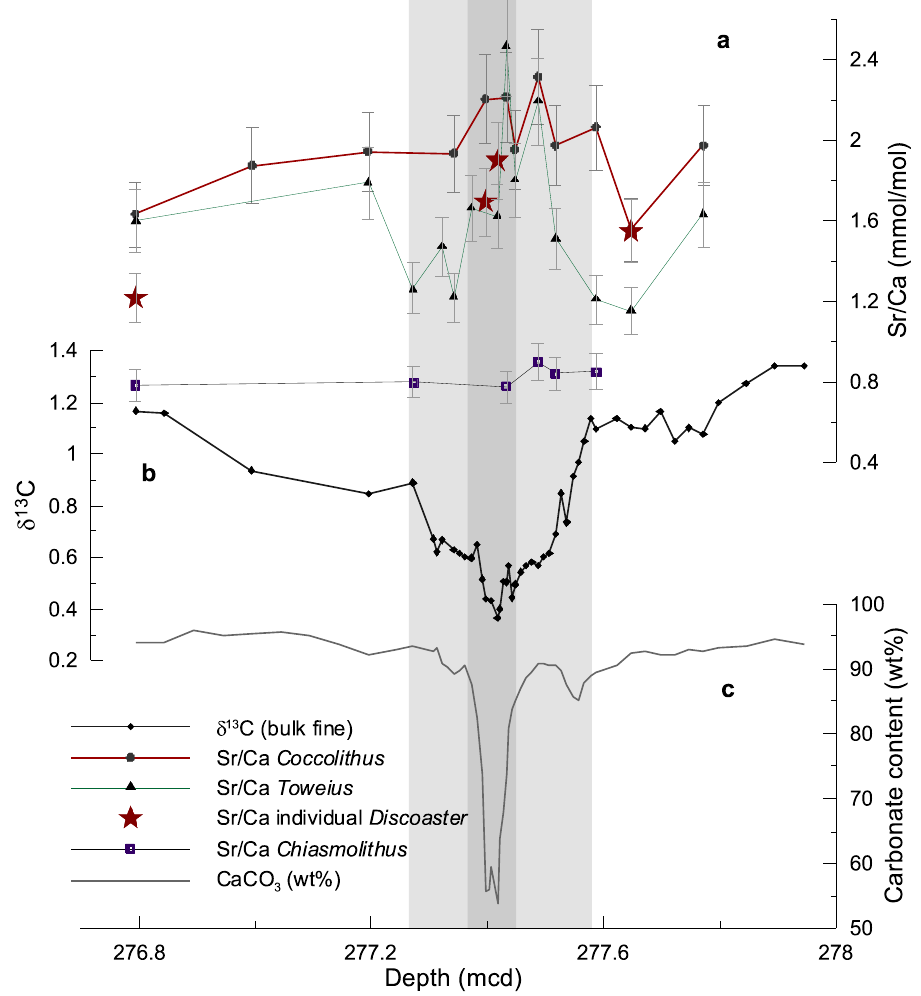
Fig. 3. (a) Sr/Ca productivity trend measured by ion probe in picked individuals or populations in correlation with the δ 13 C (Dedert et al., 2012a) across ETM2, Site 1265. Coccolithus pelagicus (grey dots), Toweius (black triangles), Discoaster (red stars), and Chiasmolithus (purple squares), (b) the carbonate content across the ETM2 interval, (c) the sediment carbonate content. Light grey bar indicates the CIE, dark grey bar marks the Elmo